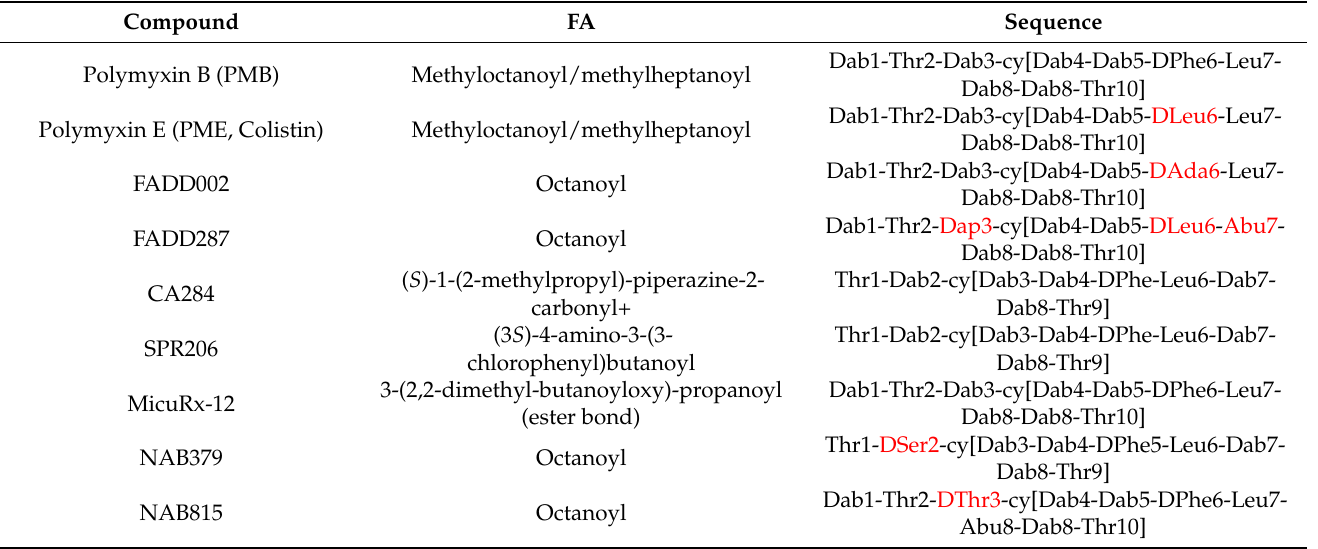
Figure 1. ( A ) The primary structure of PMB. Both PMB and PME contains cationic Dabs at positions 4, 5, 8, and 9 along with a polar Thr10 residue in their cyclic structures. ( B ) 3-D structure of PMB represented by a stick model [35] . ( C ) The docked structure of PMB-LPS complex shows that the cyclic region of PMB (stick model) binds to lipid A moiety of LPS (space filling model) predominantly by ionic/salt bridge interactions. ( D ) Summary of the epitope mapping of PMB in complex of LPS based on 1 H 1D STD experiments (red color) and natural abundance 13 C- 1 H HSQC experiments (blue color) [54] . The structure of PMB is represented as solid stick. The protons are depicted as sphere of different sizes based on determined STD values. ( D ) is reproduced from reference 54 upon permission obtained from the publisher. Table 1. Polymyxin B, colistin, and the novel polymyxin based analogs with improved efficacy in animal infection models [51] a,b